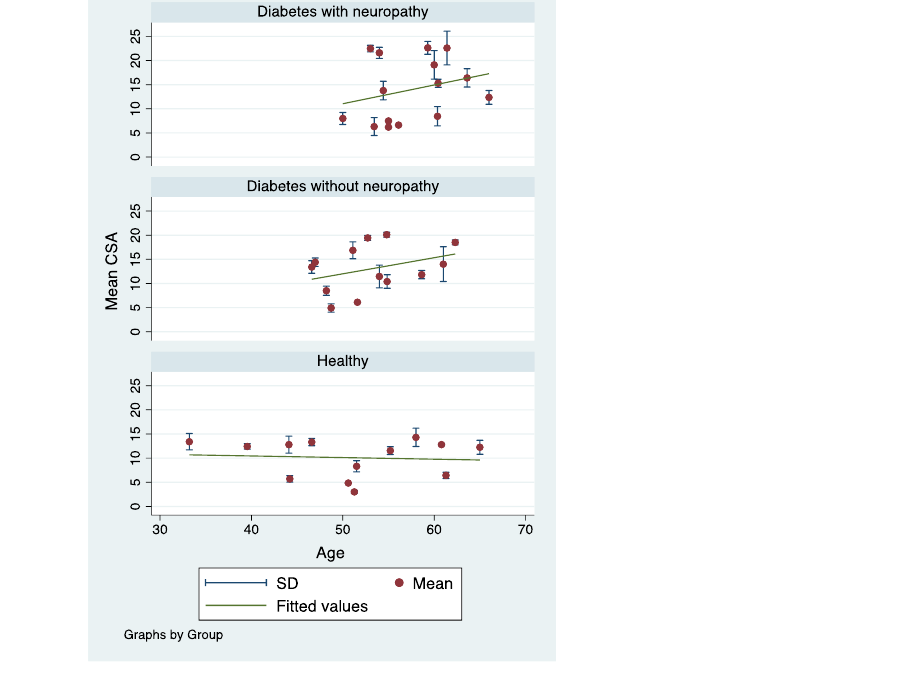
Figure 4. Correlation between mean tibial nerve CSA and age in diabetic patients, diabetic patients with neuropathy, and healthy controls.